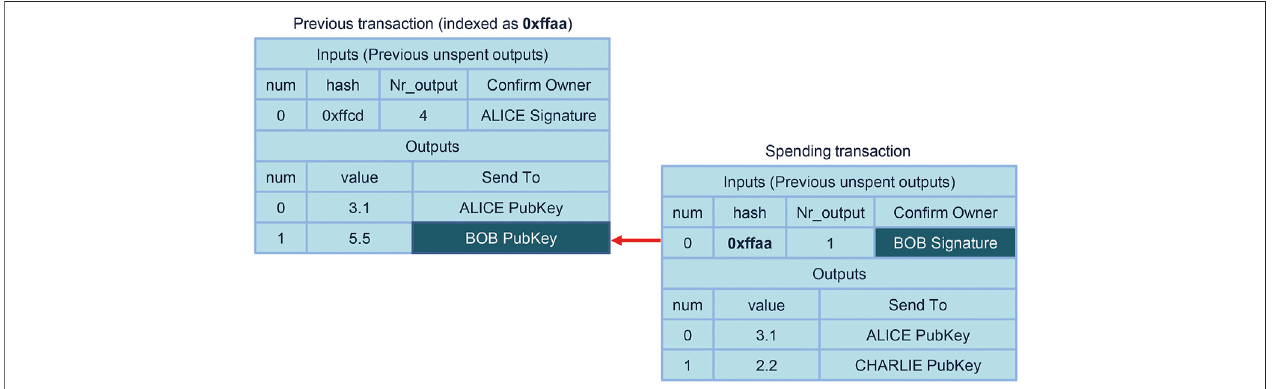
FIGURE 1 | The input to one transaction is the output of a previous transaction. Here Bob con fi rms with his digital signature that he is the owner of the private key correspondingtothepublickeyusedwhenspecifyingtherecipientofthefundsintheprevioustransaction.Transactionsreferenceeachother via theirhash(i.e.0xffaain this case).